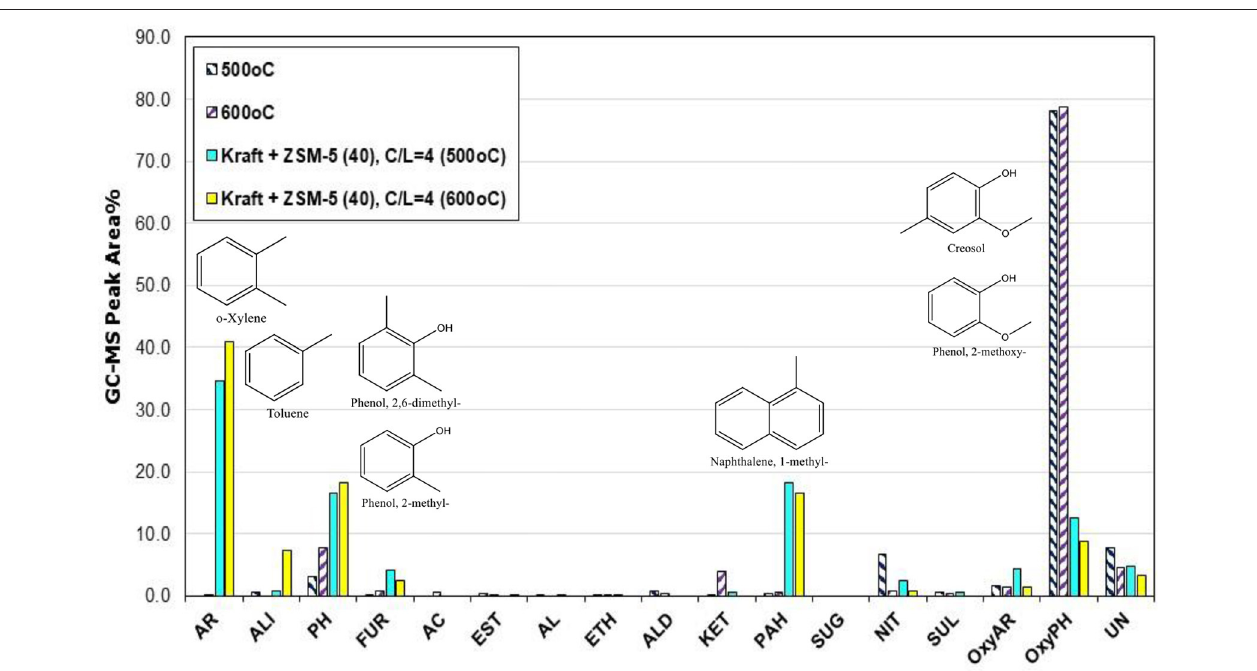
FIGURE 7 | Relative concentration of the various groups of compounds in the bio-oils derived by catalytic fast pyrolysis (CFP) of kraft lignin with ZSM-5(40) zeolite at 600 ◦ C and at different catalyst-to-lignin (C/L) ratios of 1, 2, 3, and 4; indicated compounds in the graph refer to the experiment at C/B = 4.